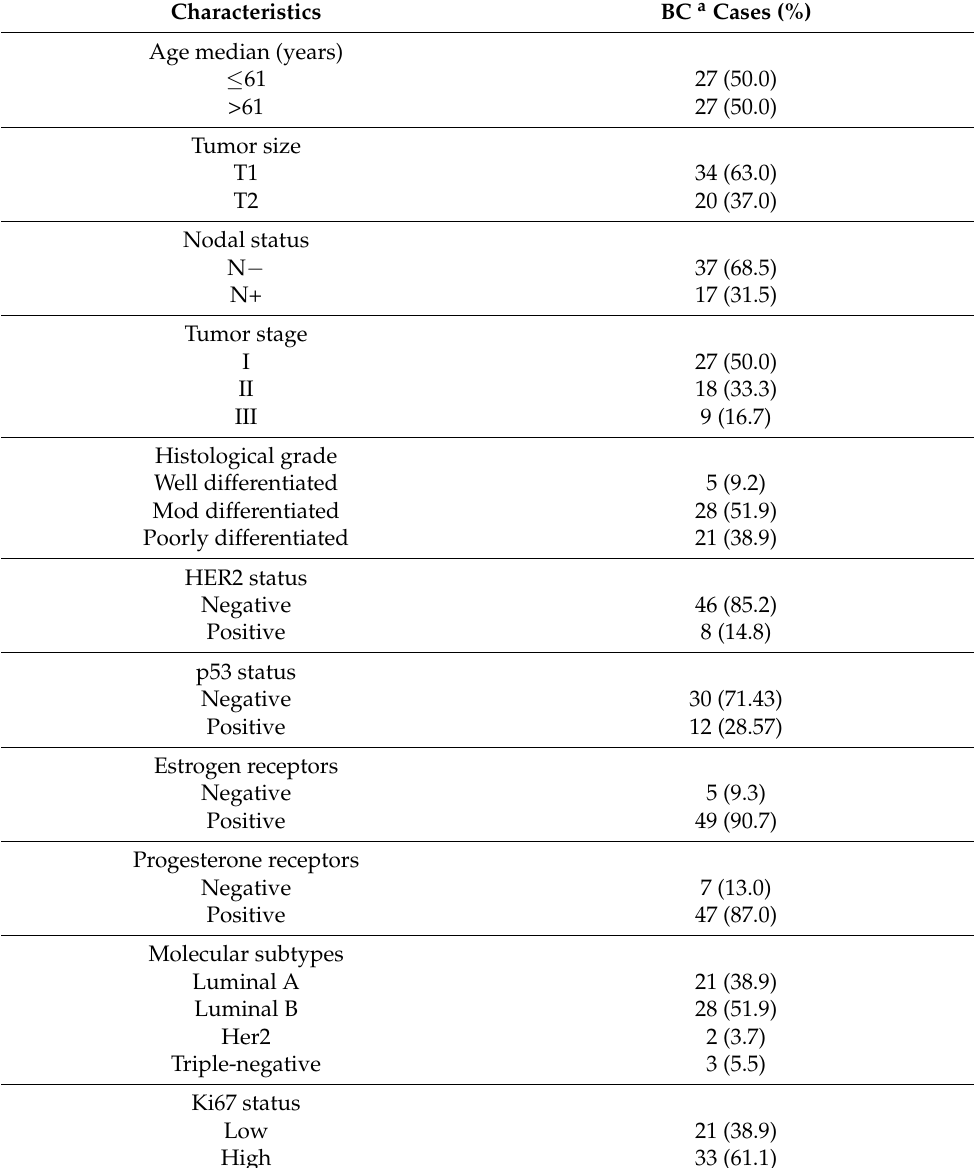
Table 3. Basal characteristics of the 54 patients with breast